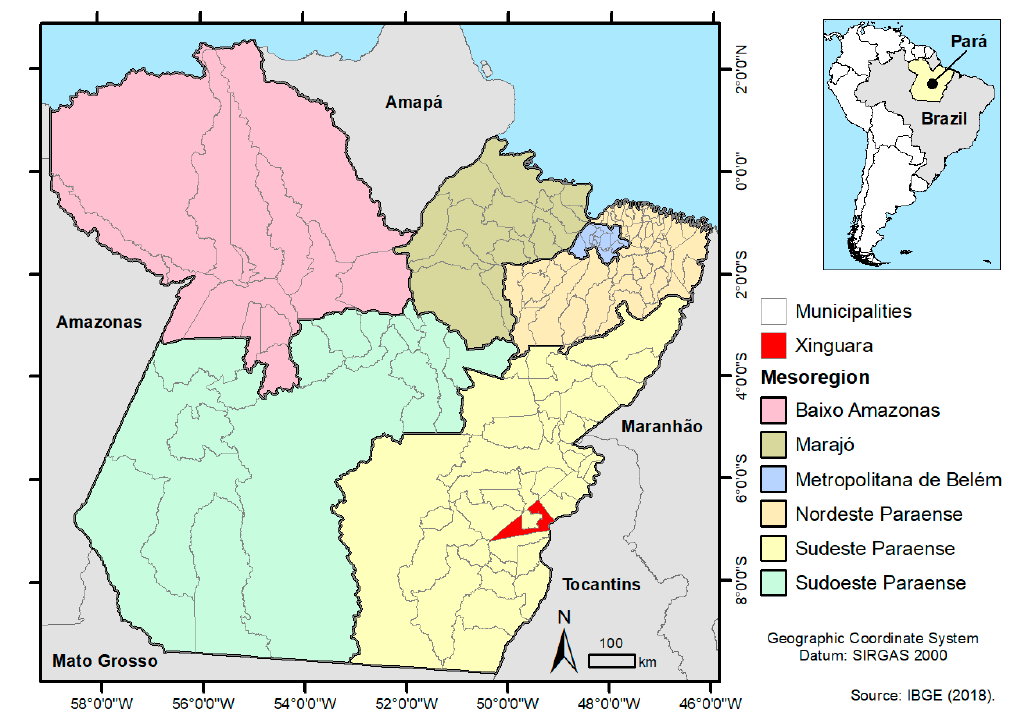
Figure 1. Study area. Municipality of Xinguara, located in the Southeast Mesoregion of the state of Pará, North Brazil.